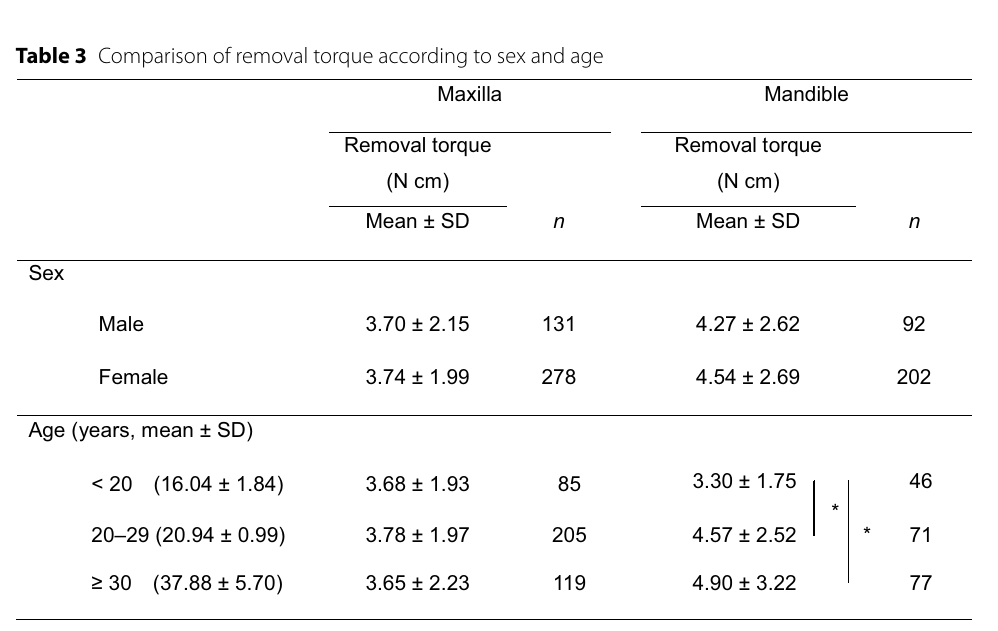
Fig. 5 Error bar plot of the mean placement and removal torque values according to placement sites. * p < 0.05, ** p < 0.001